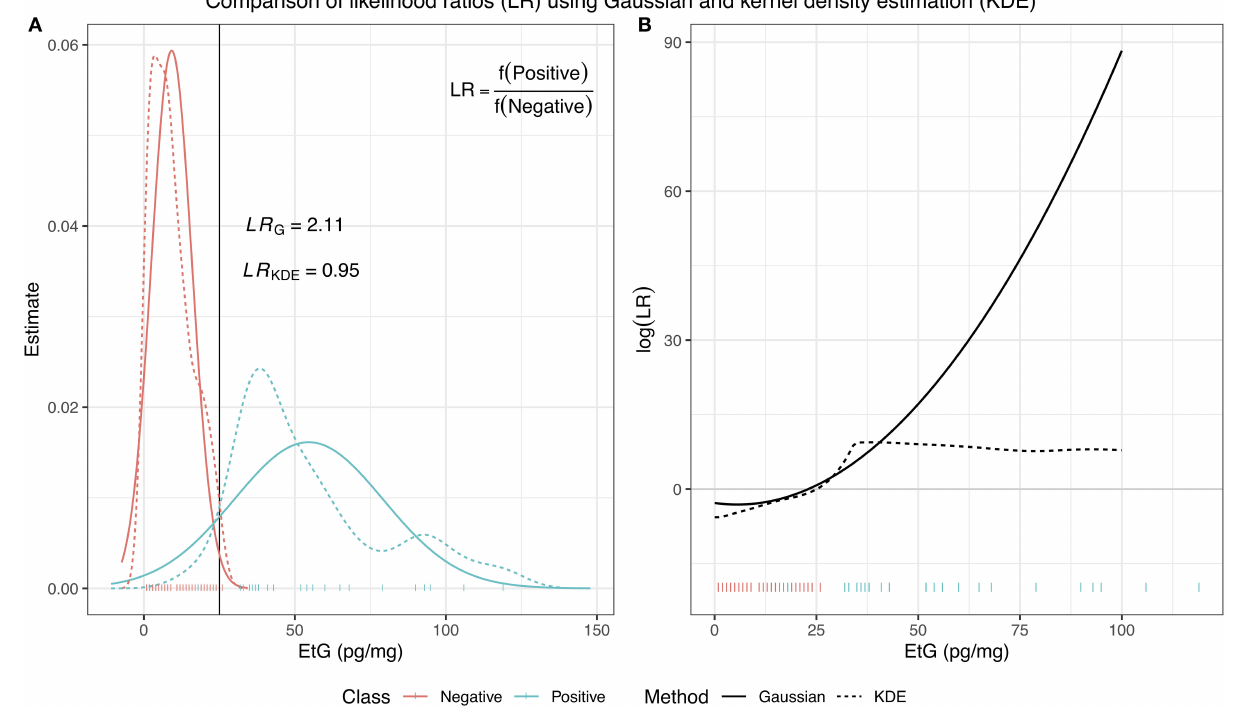
FIGURE 1 | A comparison of LRs using two different methods of density estimation: a Gaussian distribution and kernel density estimator. In (A) , for an EtG value of 25, the Gaussian LR has a value of 2.11, indicating the class of an observation with this EtG value should be positive, while the KDE LR has a value of 0.95, indicating that the observation provides similar support for membership of either class. (B) Shows the resulting log(LR) evaluated for observations with EtG values between 0 and 100 and illustrates how different the results can be depending on the choice of estimation for the underlying distribution of the data.